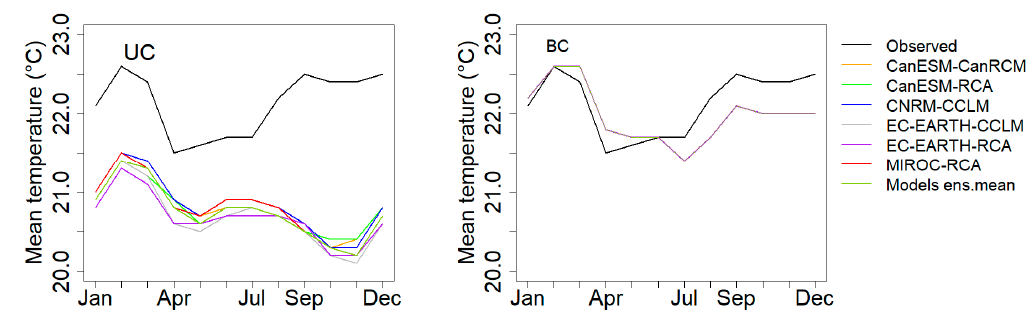
Figure 6. Mean monthly temperatures (1976–2005). UC is non-bias-corrected, BC is bias-corrected.